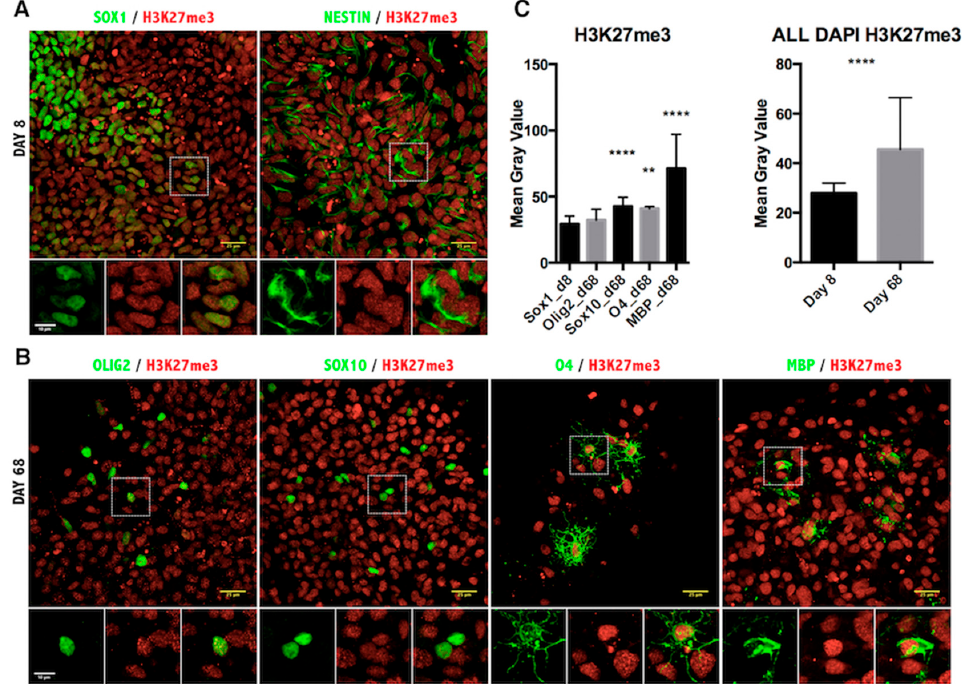
Figure 6. Immunofluorescence analysis of histone H3 lysine 27 trimethylation in iPSC-derived oligodendrocyte lineage cells. ( A ) Representative images of Day 8 of the oligodendrocyte differentiation protocol co-stained for NSC markers SOX1, NESTIN and the H3K27me3 antibody; ( B ) Images from Day 68 of differentiation co-stained for oligodendrocyte markers OLIG2, SOX10, O4, MBP and H3K27me3 antibody. Scale bar = 25 µm. The magnified view of the broken line box area appears as the inset with the individual channels and the merged image. Scale bar = 10 µm; ( C ) Quantitation of the immunofluorescence signal as the mean gray value in cells expressing the indicated markers ( left ) or in all DAPI-positive cells per field ( right ). Results are represented as the mean with the SD. ** p < 0.001; **** p < 0.0001.